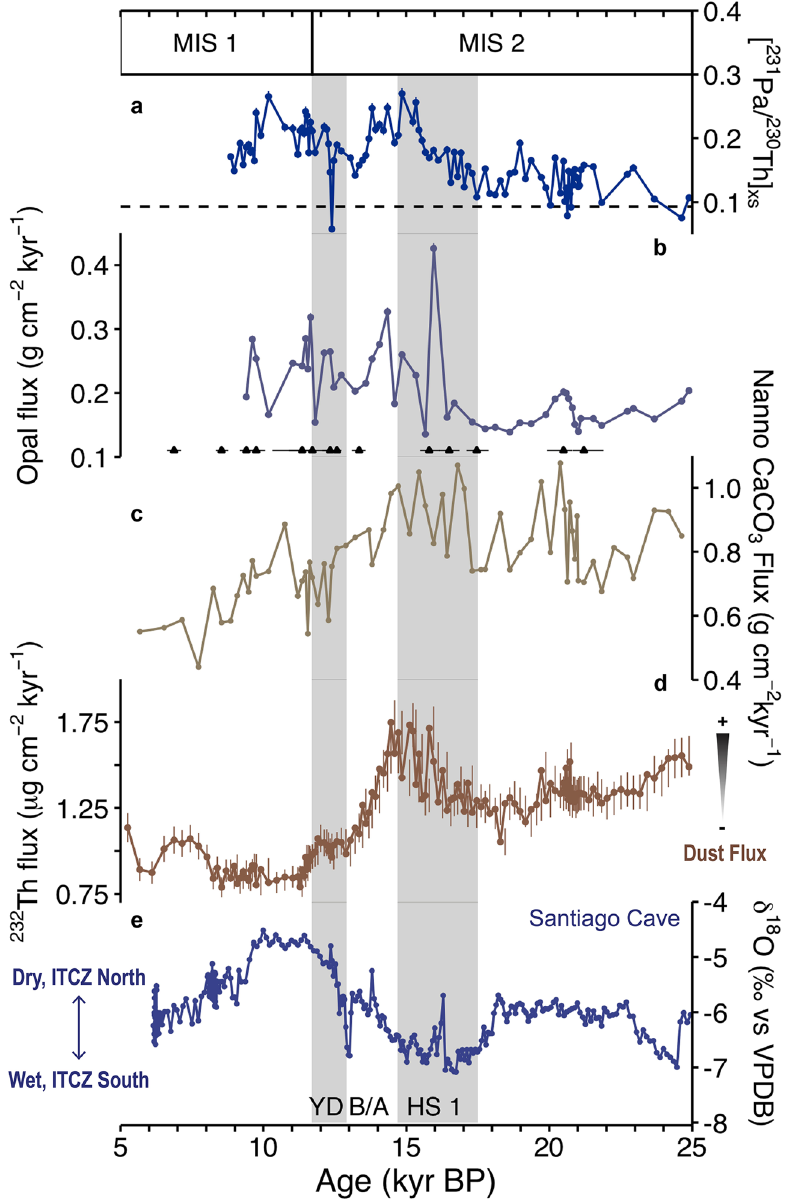
Stadial 1 (HS1), the Bølling-Allerød (B/A), and the Younger Dryas (YD)- of the deglacial from McManus et al. 29 (grey shaded bars represent cold stadials). ( a ) 17JC Initial [ 231 Pa/ 230 Th]xs and the 231 Pa/ 230 Th production ratio of 0.093 (dashed black line), ( b ) 17JC 230 Th-normalized opal fluxes, ( c ) 17JC 230 Th-normalized nannofossil carbonate fluxes, ( d ) 17JC 230 Th-normalized 232 Th (dust) fluxes 11 , and ( e ) Santiago Cave δ 18 O calcite 13 . Vertical lines through data points represent error bars (see Supplemental Table 2); those not visible are smaller than the data point symbol. Black triangles in panel b mark the radiocarbon ages and associated uncertainties (horizontal bars) for 17JC (see